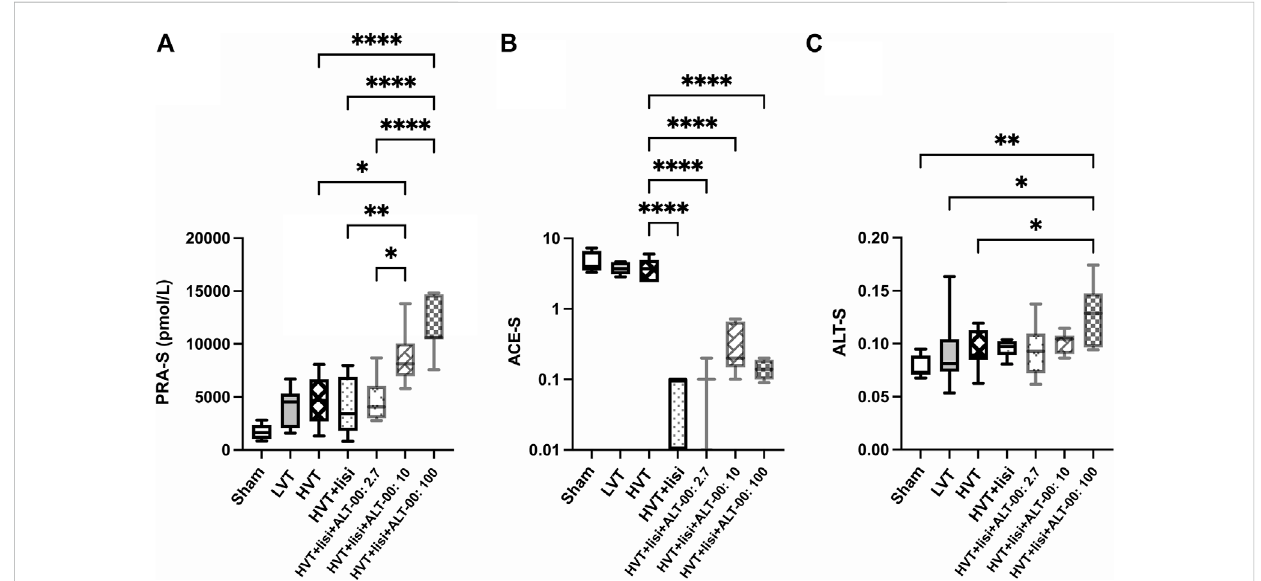
FIGURE 7 Angiotensin metabolite-based markers of angiotensin cleaving enzyme activities in plasma. (A) PRA-S (Ang I + Ang II) as a marker of plasma renin activity was increased following treatmentwith lisinopril (lisi) combined with ALT-00 atdose levels of 10 and 100 μ g/kg/min versus the high tidal volume (HVT), HVT + lisi, and HVT + lisi + ALT-00 (2.7 μ g/kg/min) groups. (B) ACE activity in plasma (Ang II/Ang I ratio, ACE-S) was downregulated in all groups treated with lisi ± ALT-00 versus the HVT group. (C) The alternative RAS activation marker ALT-S was increased by ALT-00 at a dose level of